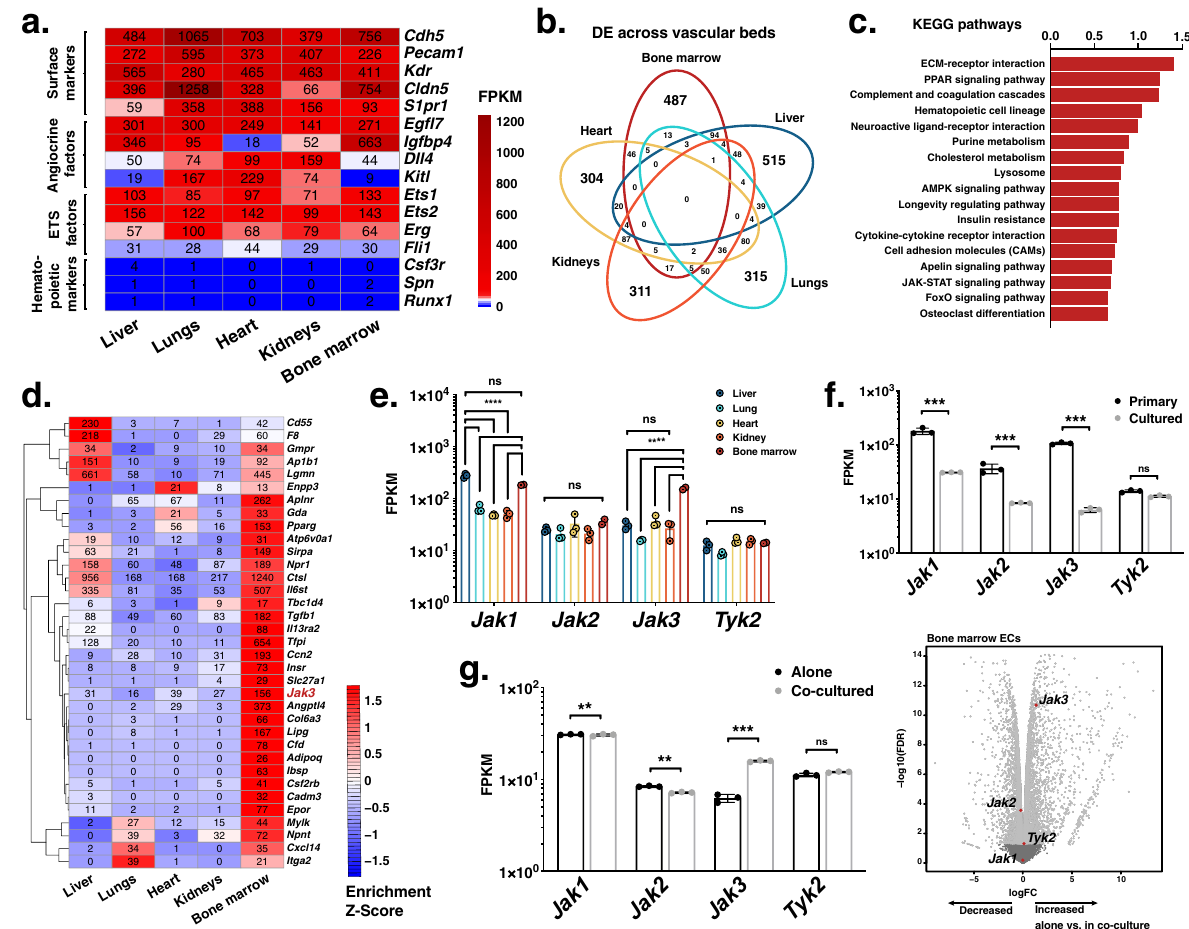
Fig. 1 Endothelial expression of Jak3 is enhanced by a hematopoietic milieu in vitro and in vivo. a Heatmap depicting absolute transcript abundances of genes of interest obtained by RNA sequencing (RNA-seq) of primary murine endothelial cell (EC) populations extracted from the indicated vascular beds. Average FPKM values for all biological replicates ( n = 2 or 3 per organ) appear in black. b Venn diagram showing number of intersecting overrepresented gene transcripts resulting from differential expression analyses of each vascular bed against all other samples (FDR < 0.05). c Bar plot of enrichment scores of the 15 most upregulated Kyoto Encyclopedia of Genes and Genomes (KEGG) 54 – 56 terms generated by gene set enrichment analysis (GSEA) using the log 2 fold change of the differentially expressed gene transcripts in the bone marrow vasculature compared to that of the liver, lungs, heart, and kidneys. d Heatmap depicting normalized transcript abundances of genes that contributed to the 15 most upregulated KEGG terms by GSEA. Average FPKM values for all biological replicates ( n = 2 or 3 per organ) appear in black. Jak3 , the most highly and differentially expressed transcript, is highlighted in red. e Janus kinase (Jak) family gene expression across the organs assayed as measured by RNA-seq. **** p value < 0.0001 and ns (not signi fi cant) > 0.05, by two-way ANOVA. f Jak family transcript expression in primary vs. cultured bone marrow ECs (BMECs) as measured by RNA-seq ( n = 3 per group). Raw data were obtained from Poulos et al. 26 (GEO: GSE61636) and re-analyzed for this publication. *** p value < 0.001 and ns > 0.05, by unpaired, two-tailed Student ’ s t test. g Jak family transcript expression in BMECs cultured alone vs. in contact with hematopoietic stem and progenitor cells for 8 days as measured by RNA-seq ( n = 3 per group; left). Volcano plot illustrating differential expression analysis of these data (right). Jak family gene transcripts are highlighted with enlarged dots in red; respectively, light or dark gray dots indicate gene transcripts differentially expressed above or below cutoffs, – log 10 ( p value) < 1 and |log 2 FC| < 2.5. Raw data were obtained from Poulos et al. 26 (GEO: GSE61636) and re-analyzed for this publication. *** p value < 0.001, ** p value < 0.01, and ns (not signi fi cant) > 0.05, by unpaired, two-tailed Student ’ s t test. On all plots, each replicate is represented by an individual dot and error bars represent standard deviation from the